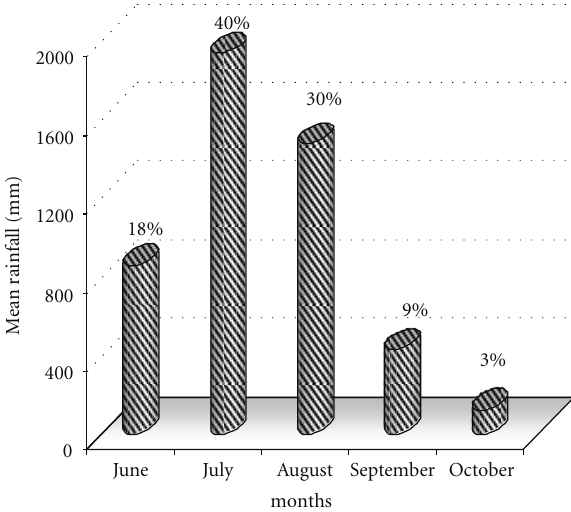
Figure 2: Monthly average rainfall (mm) over the Koyna catch- ment.